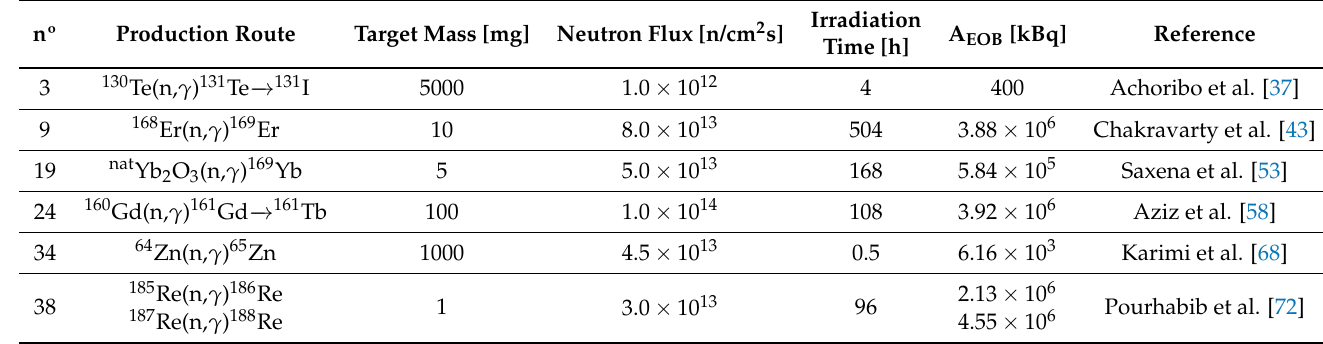
Table A3. Research reactor-produced radioisotopes.